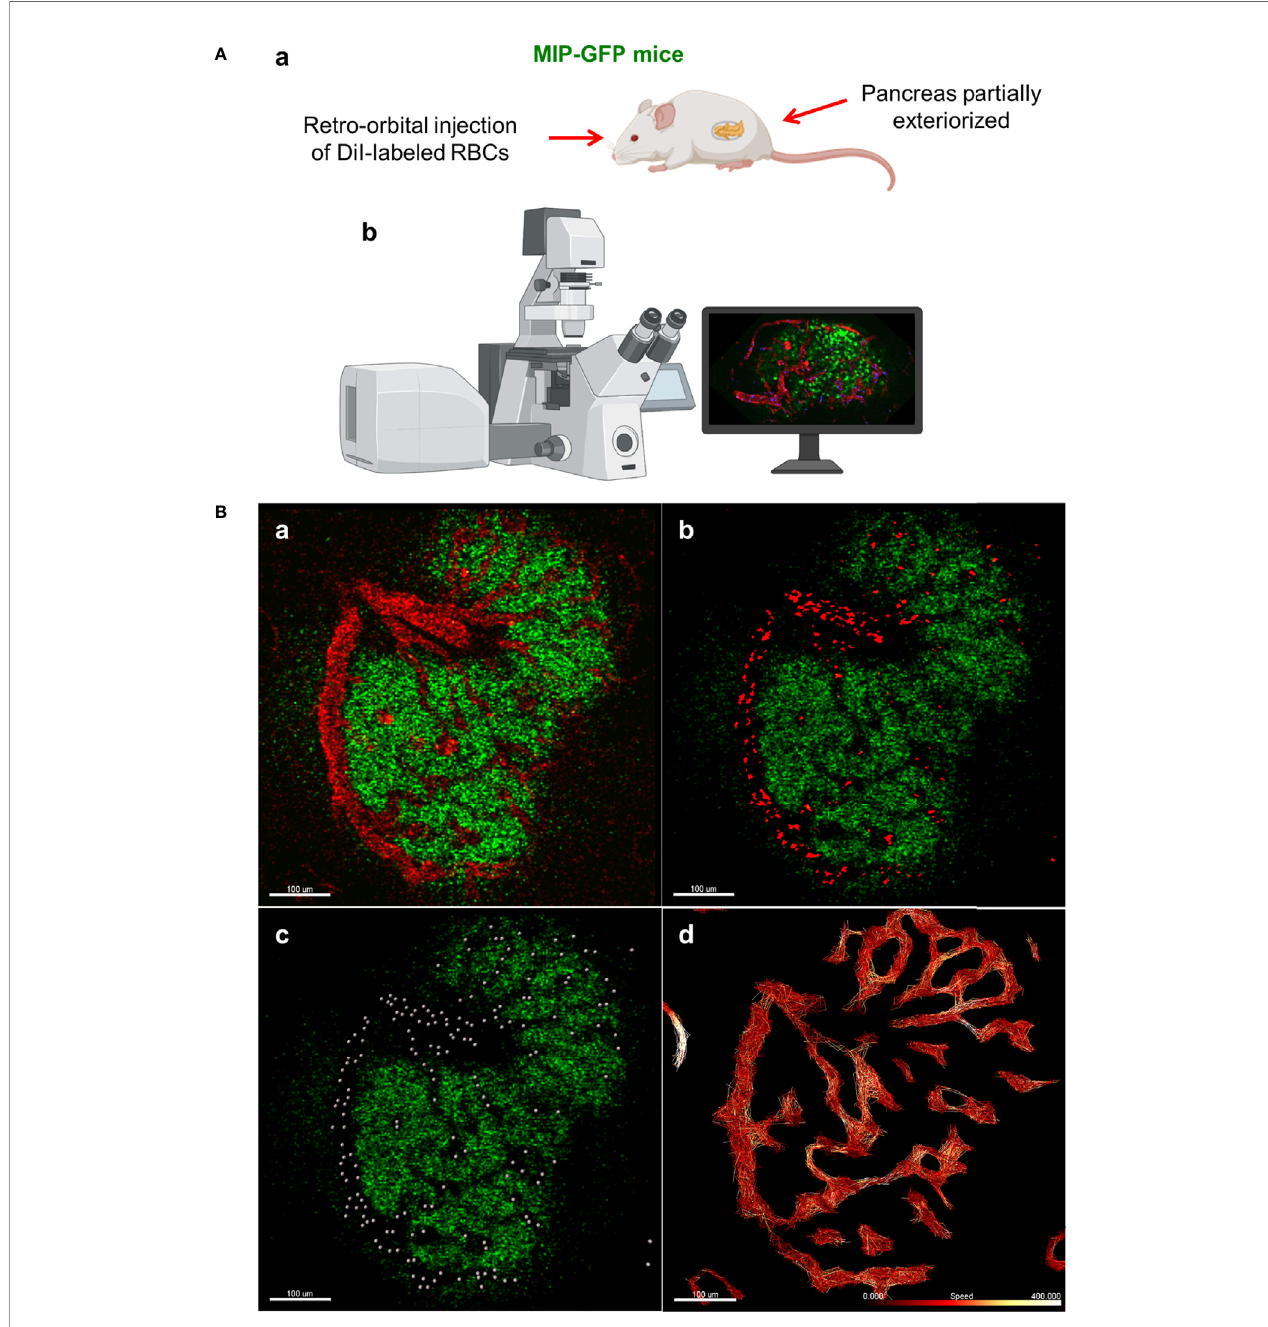
FIGURE 1 | In vivo approach to study islet microcirculation in mice. (A) a. MIP-GFP mice are anesthetized with ketamine (100 mg/kg) (Fort Dodge AnimalHealth, Fort Dodge, IA) and xylazine (5 mg/kg) (Ben Venue Laboratories, Bedford, OH). After depilation, a pancreas is exteriorized. To visualize the blood fl ow, 10 8 RBCs stained with DiI (Thermo Fisher Scienti fi c, Waltham, MA) and/or tetramethylrhodamine (TMRD)-labeled dextran (2,000,000 MW) (Thermo Fisher Scienti fi c) are injected intravenously in the mice just before imaging. b. Intravital microscopy is conducted using Leica TCS SP5 MP confocal microscope (Leica Microsystems, Mannheim, Germany). Images are recorded and analyzed using Leica LAS-AF as well as Fiji (http://imagej.net/Fiji). (Created with BioRender.com) (B) a. Fluorescent signal of dextran in mouse islet vasculature. b. Fluorescent signal of labeled individual RBCs in mouse islet vasculature. Scale bar: 100 µm. c. Computer-generated spheres representing tracked RBCs. d. Heatmap of RBC speed within the islet (fast to slow, white to red). Scale bar: 100 µm. (Adopted from